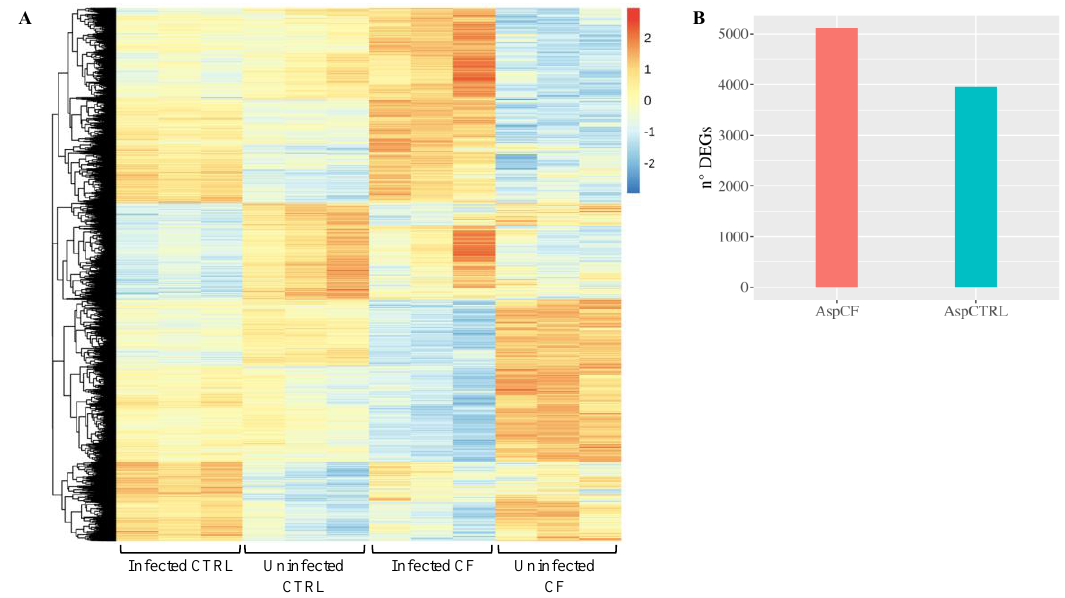
Figure 4. Transcriptional response to infection. ( A ) The heatmap represents the expression (rlog row-scaled) of DEGs obtained in the AspCTRL and AspCF comparisons. ( B ) DEGs numbers. AspCTRL: DEGs between infected and uninfected CTRL cells; AspCF: DEGs between infected and uninfected CF cells.